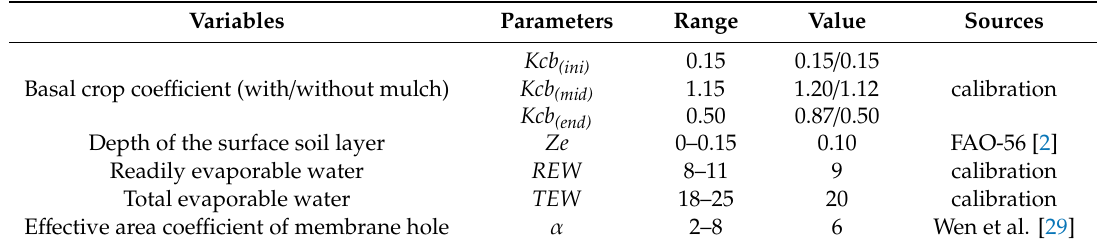
Table 3. Parameters for the dual crop coe ffi cient approach that was used to estimate evapotranspiration of summer maize on plots in Xinjiang, China. Variables Parameters Range Value Sources Kcb (ini) Kcb (mid) Basal crop coe ffi cient (with / without mulch)